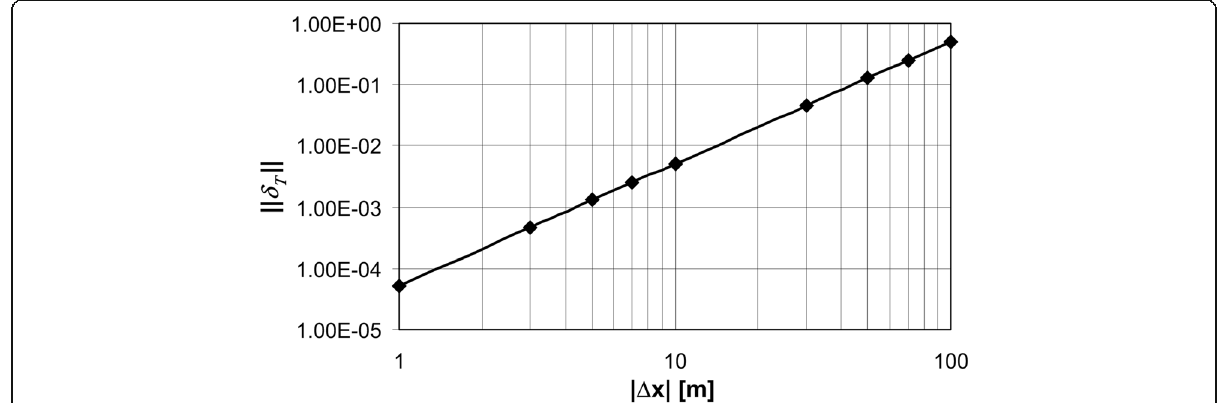
Fig. 4 The mean value from the norm of δ T vector as a function of the absolute value Δ x